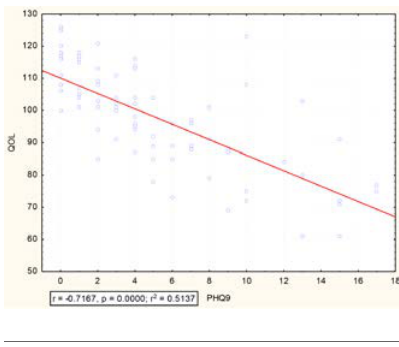
Figure 1. Correlation between Patient Health Questionnaire nine-item and the health-related quality of life rates.